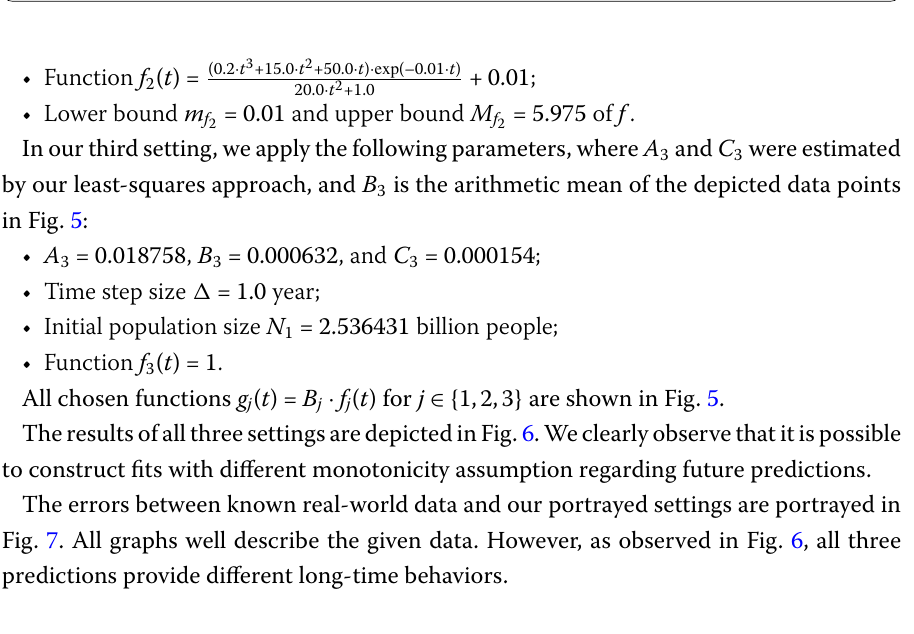
Figure 5 The results of our nonnegative linear least-squares optimization can be seen as the blue graph. All three different settings are depicted in different colors as given in the